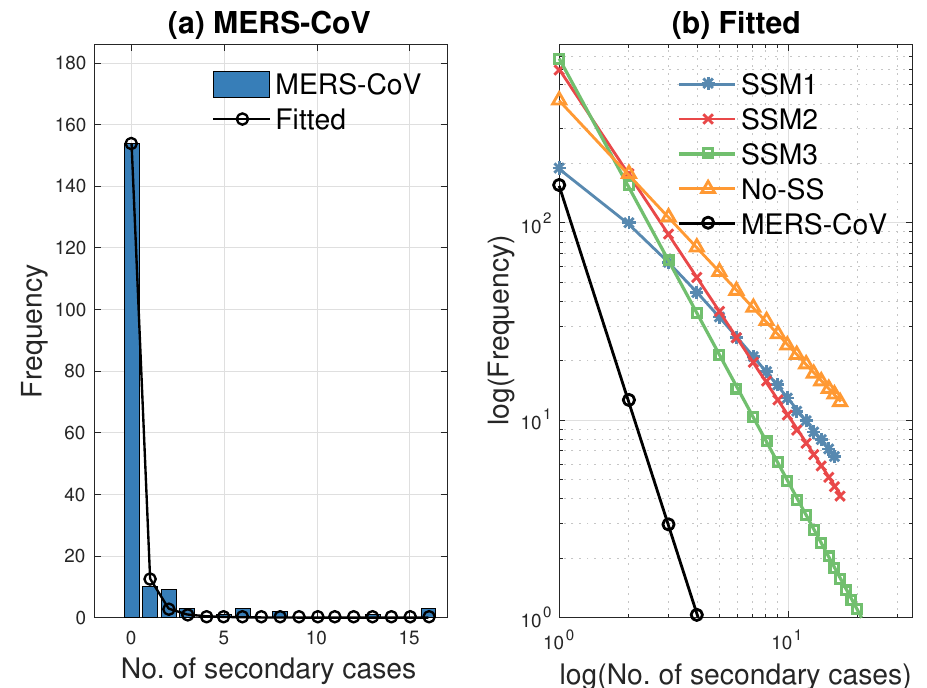
Figure 11. ( a ) Distribution of secondary cases for the 2015 Korean MERS-CoV data and its fitted power law distribution are illustrated. ( b ) Four fitted power law distributions using λ = 10% are compared with MERS-CoV data. SSM3 shows the best fit to the distribution of secondary cases of the MERS-CoV data (see the slopes of the squared and circled